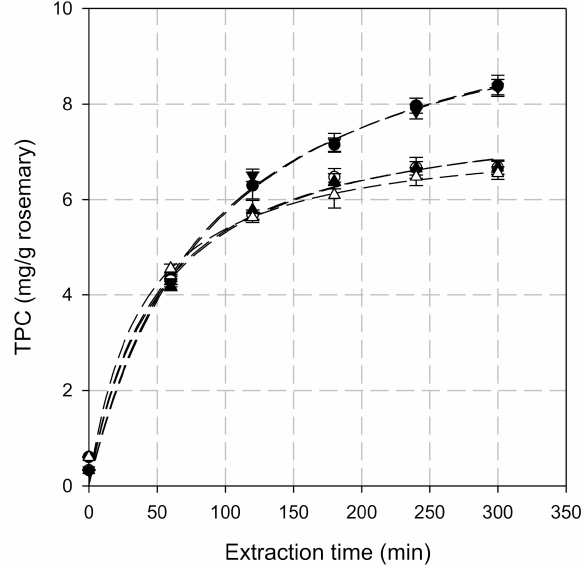
) Cellic CTec2, (cid:35)